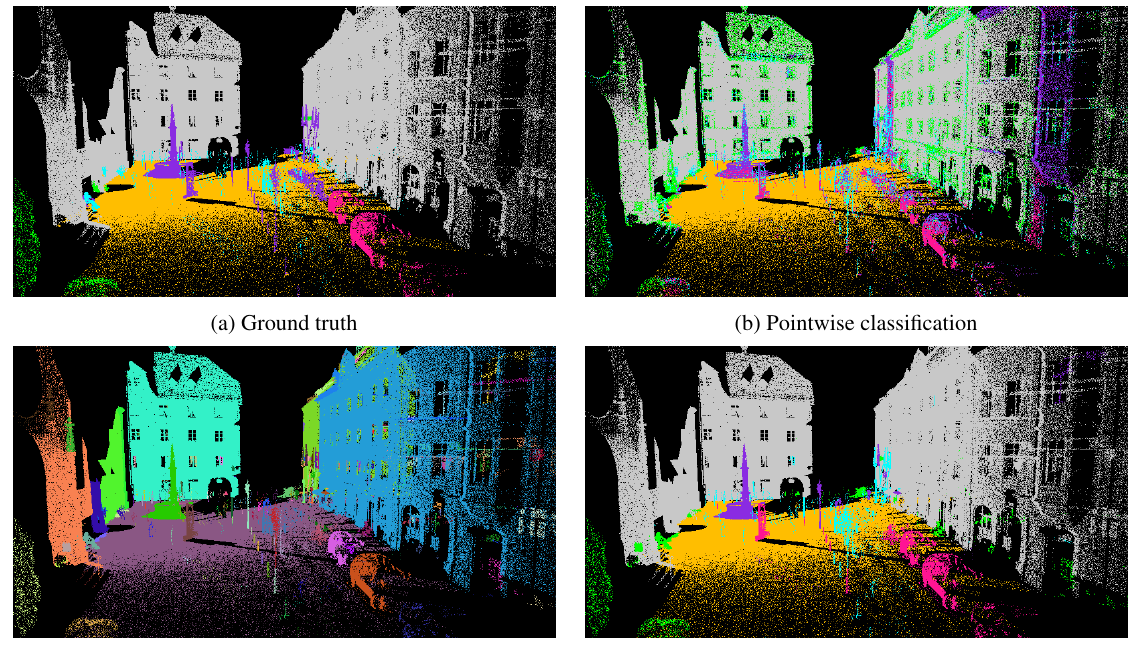
Figure 1. Illustration of the different steps of our method: the pointwise, irregular classification 1b is combined with the geometrically homogeneous segmentation 1c to obtain a smooth, objects-aware classification 1d. In Figures 1a, 1b , 1d, the semantic classes are represented with the following color code: vegetation, façades, hardscape, acquisition artifacts, cars, roads. In Figure 1c, each segment is represented by a random